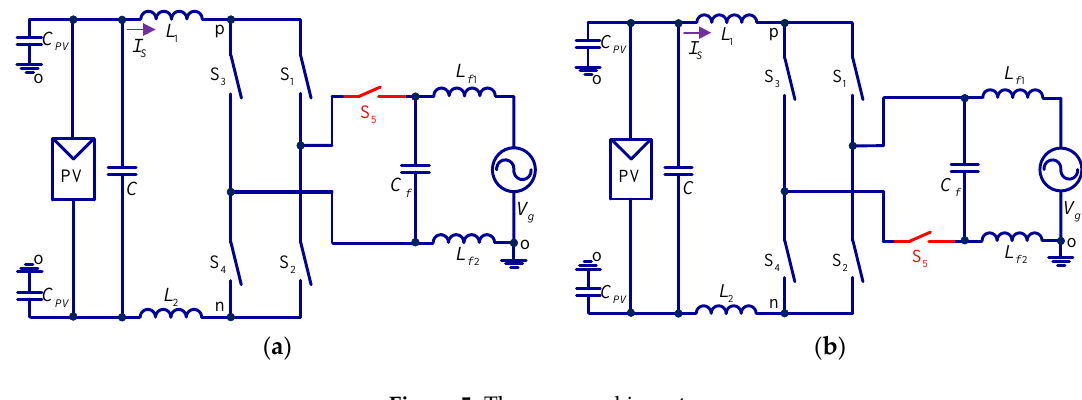
Figure 4. The VH6 inverter.